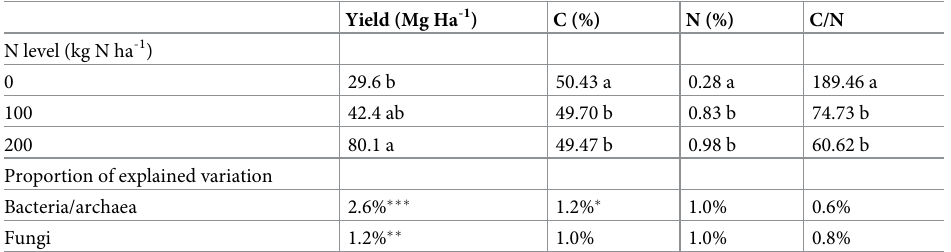
Table 2. Above-ground biomass yields and plant C/N contents of switchgrass affected by N fertilization levels as well as their association with community structure of bacteria/archaea and fungi by marginal test of DistLM. Dif- ferent letters within each column indicate significant effects by N fertilization levels at α = 0.05. The � , �� , and ��� indi- cate significant DistLM relationship at α = 0.05, 0.01, and 0.001,